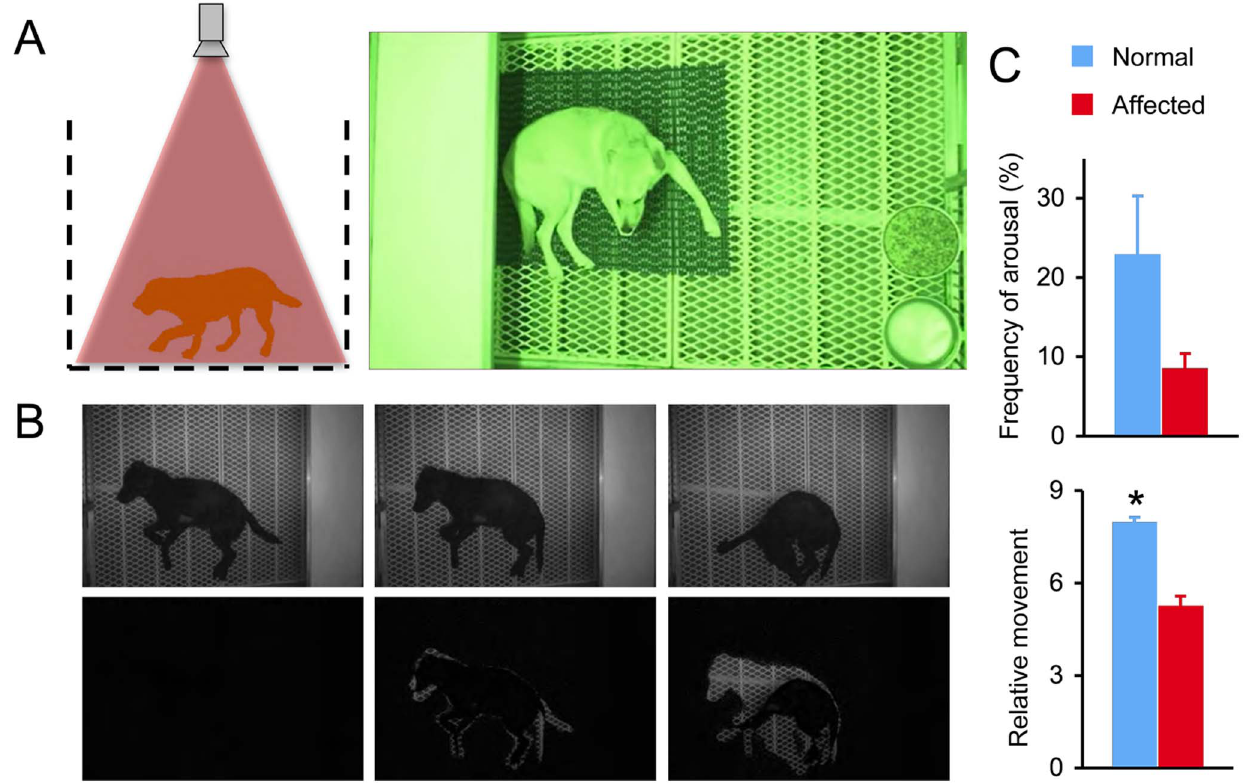
Figure 3. Dystrophic dogs show reduced activity during overnight monitoring. A, The set up of the overnight video monitoring system. Left panel, a cartoon illustration showing the position of the dog and the camcorder. The video recording was taken from the top of the cage to allow full visualization of the entire floor of the cage. Right panel, a representative image of a dog during overnight monitoring. B, Representative snap images at different time points of recording in a dog. Top panels, the original recording; Bottom panels, after image processing. Left panel, when the dog did not change position, the processed image shows no signal (only dark background). Middle and right panels, when the dog changed the position, the difference between the current and the previous (3 sec prior; see Method for detail) images is revealed as white/gray signals within the dark background. C, Quantification of the frequency of arousal and the relative movement. Representative overnight monitoring video clips from normal and affected dogs are shown in movie